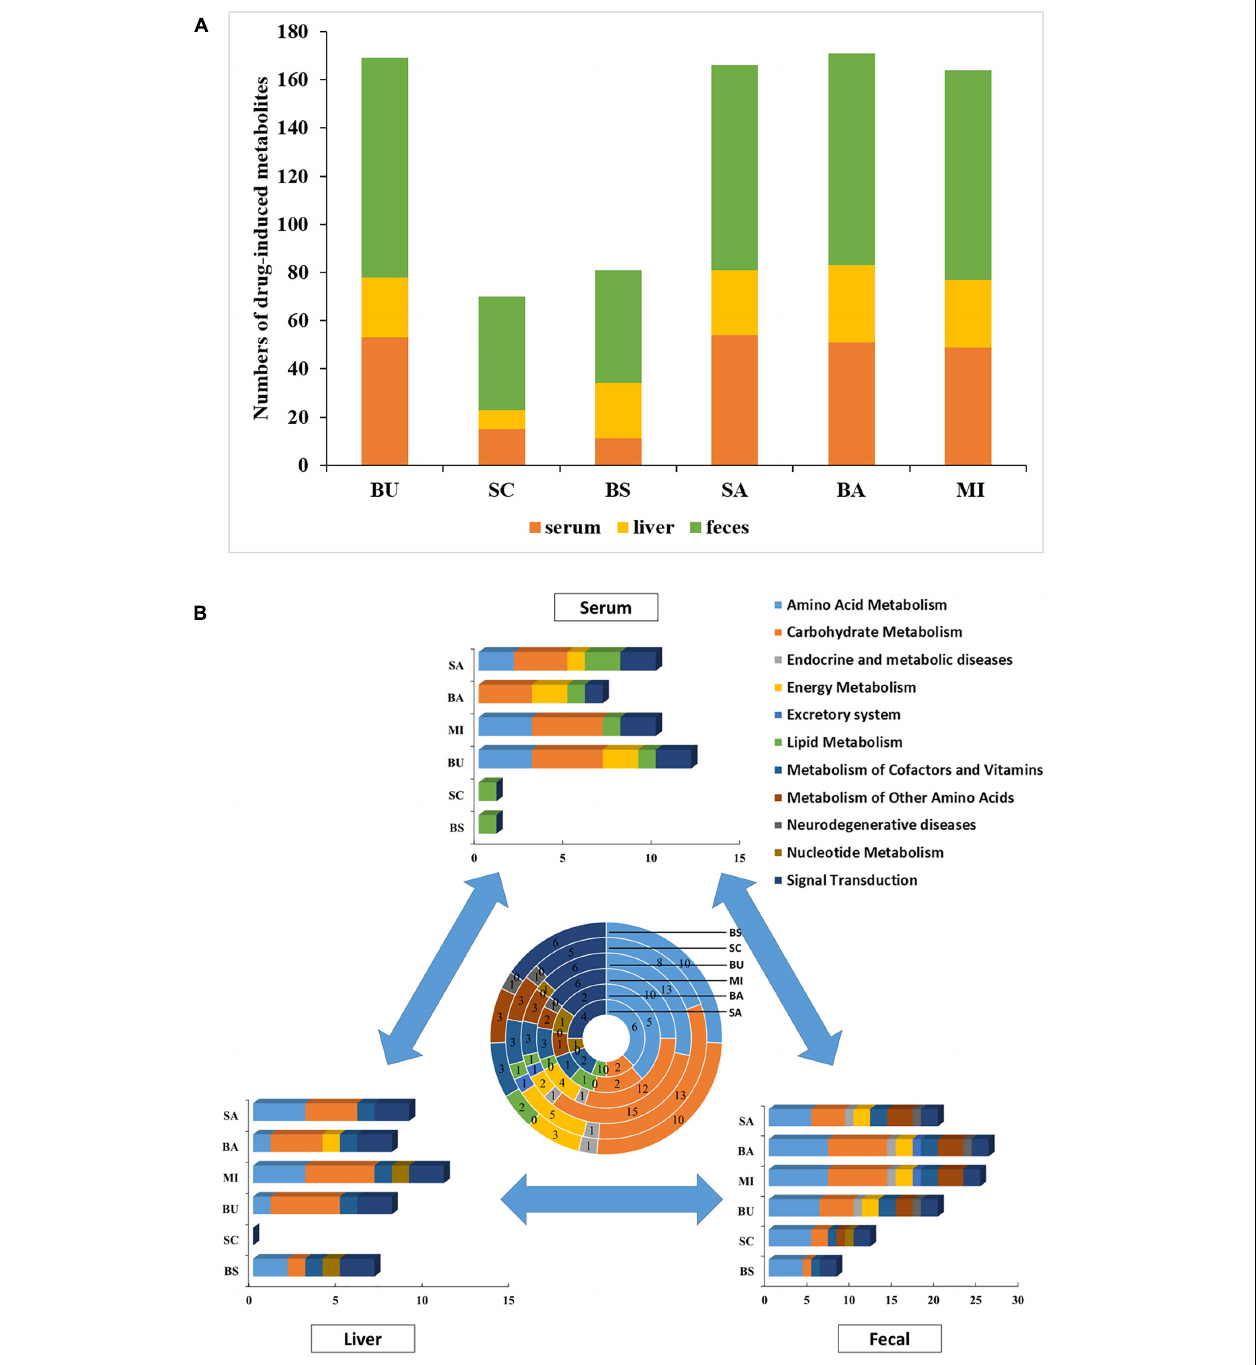
FIGURE 2 | Metabolite and pathway analysis of drug-induced perturbations. (A) Numbers of drug-intervened metabolites in ALI; (B) numbers of drug-intervened pathways in ALI. The summarization of drug-intervened global, local and symbiotic pathways is presented in the center. BS: decoctions of B. chinense-S. baicalensis ; SC: decoctions of S. baicalensis ; BU: decoctions of B. chinense ; BA: water solution of baicalin; SA: water solution of saikosaponin; MI: the mixture of baicalin and